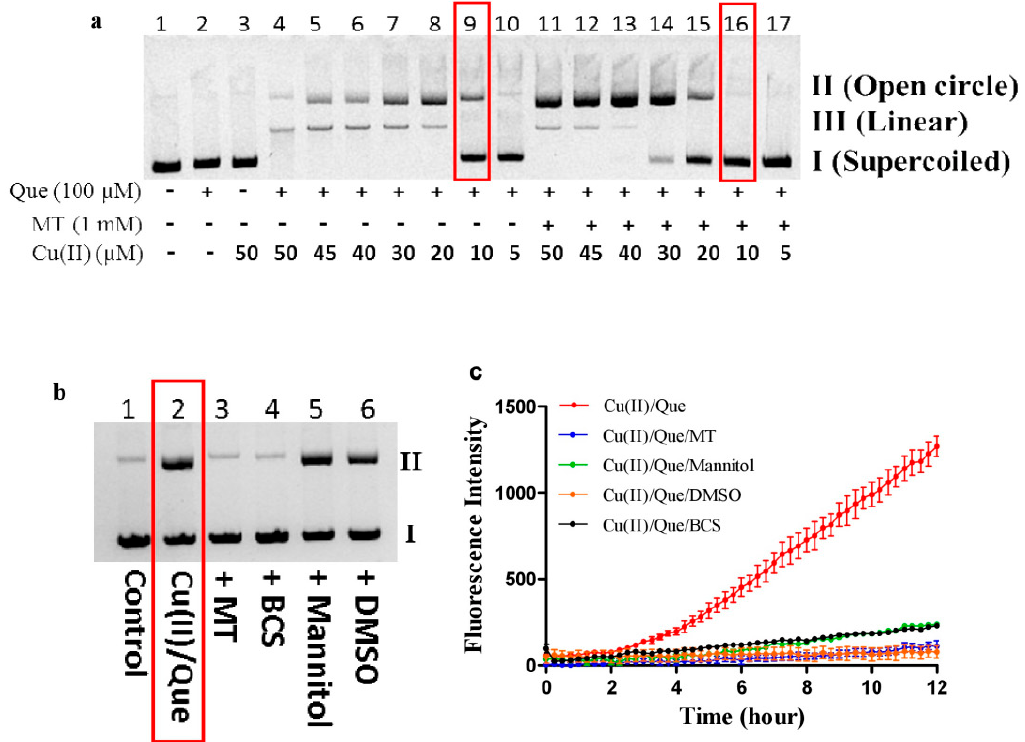
Figure 8. Melatonin prevents DNA from damage induced by copper and quercetin through chelating copper. ( a ) Melatonin (MT) protected against DNA strand breakage induced by quercetin (Que) and various concentrations of Cu(II). ( b ) The role of MT, BCS, mannitol, and DMSO in Que / Cu(II)-induced DNA strand breakage. ( c ) The synergistic production of • OH by Que and Cu(II), and the inhibition by various agents. Concentrations of each tested chemical in b and c were the same, specifically Cu(II), 10 µ M; Que 100 µ M; MT, 1 mM; Mannitol, 100 mM; DMSO, 5%; BCS, 30 µ M. In a and b, all reactions were conducted in Tris-HCl bu ff er (10 mM, pH 8.0) at 37 ◦ C for 30 min. All reaction mixtures contained 10 µ g / mL plasmid DNA. In c, • OH was measured by 3-CCA fluorescent method (3 mM). Reactions were conducted in 0.05 M PBS (pH 7.4) at 37 ◦